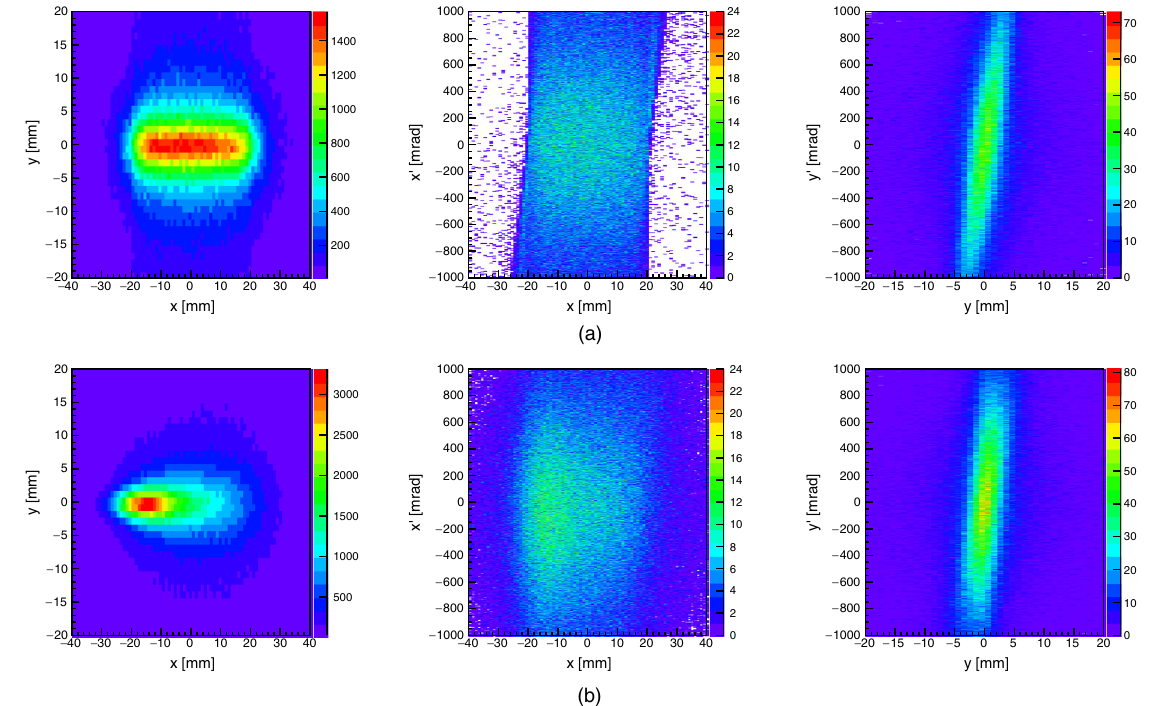
FIG. 4. (a) Real space ( x - y ) distribution and phase spaces ( x - x 0 and y - y 0 ) of the OTE. (b) Corresponding distributions of the NTE. Virtual detectors are attached to the surface of the target to record surface muons in the simulation. 10 11 protons are simulated for each target and we use “ QGSP_BIC ” as the physical model for the interaction of the proton beam for both target simulations in